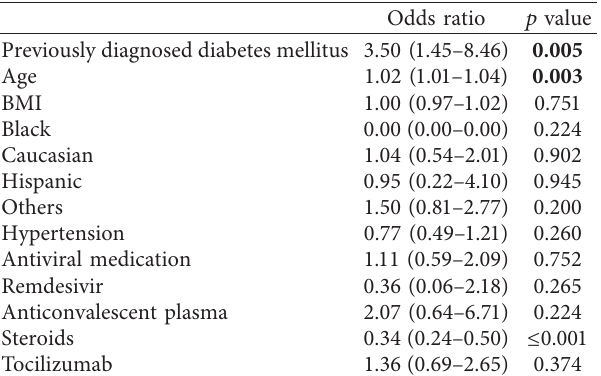
Table 7: Binomial regression for mortality in the patients with diabetes mellitus.